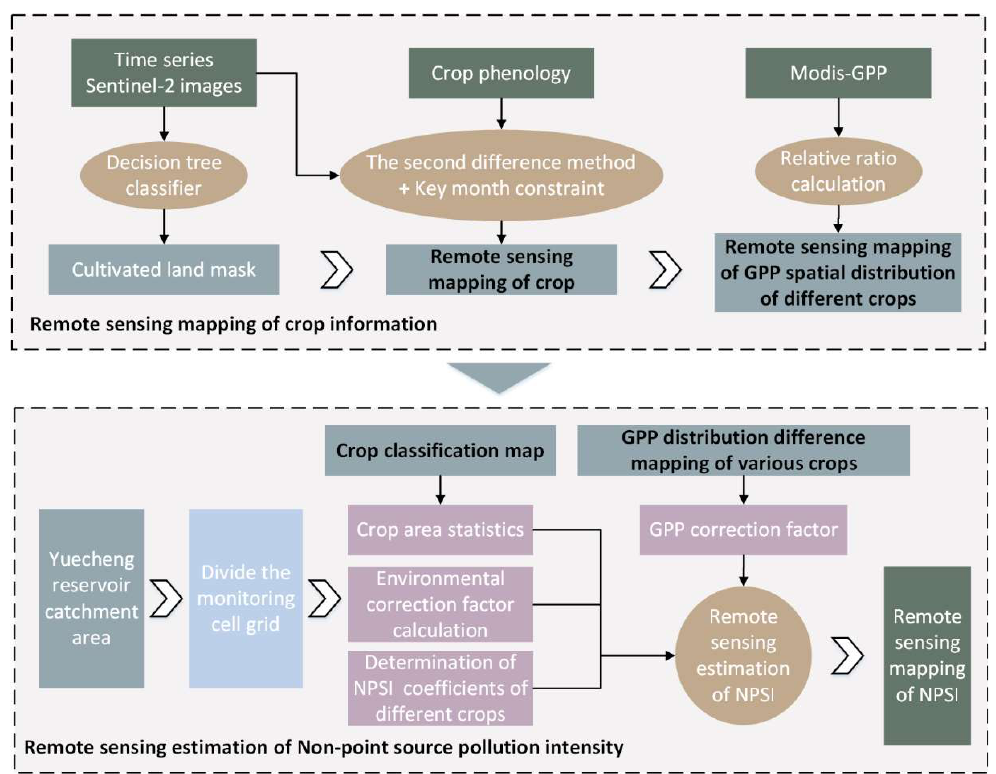
Figure 2. Flowchart depicting crop information extraction and non-point source intensity estimation.